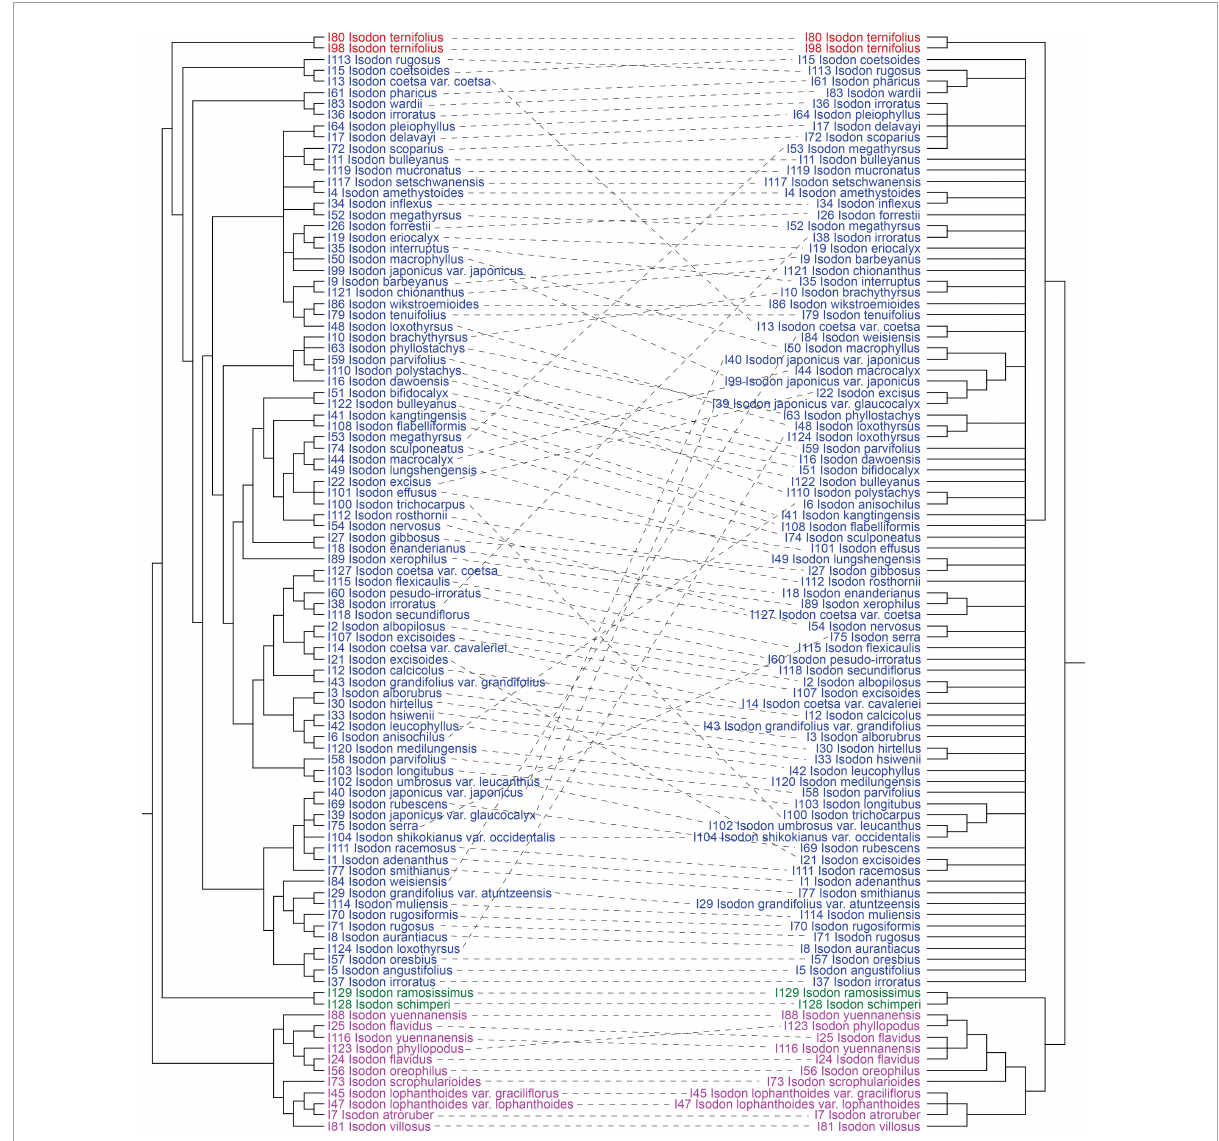
FIGURE2 Tanglegram comparing plastid (maximum-likelihood tree inferred from the CR + NCR-GB data set) and nuclear (maximum-likelihood tree inferred from the nrDNA data set) trees, optimized in Dendroscope to minimize line crossings. All clades with < 50% BS have been